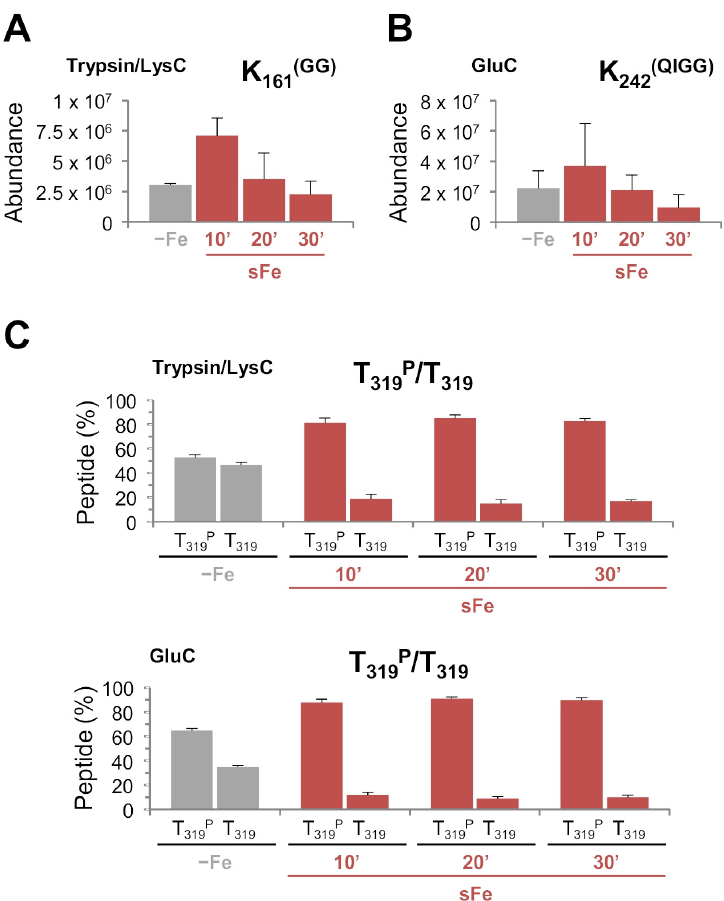
Figure 6. Ubiquitination of K161, sumoylation of K242, and phosphorylation of T319 are induced during a shift from iron-depleted to iron-replete conditions. ( A – C ) Label-free quantification of K161 ubiquitination ( A ), HapX K242 sumoylation ( B ), and T319 phosphorylation ( C ) determined by nLC- MS/MS analysis after Myc-Trap affinity purification from crude extracts of m hapX grown in AMM − Fe and then supplemented with 10 µ M FeSO 4 for 10, 20 and 30 min (sFe). Eluates were digested as indicated. Bars represent standard deviations from three independent biological